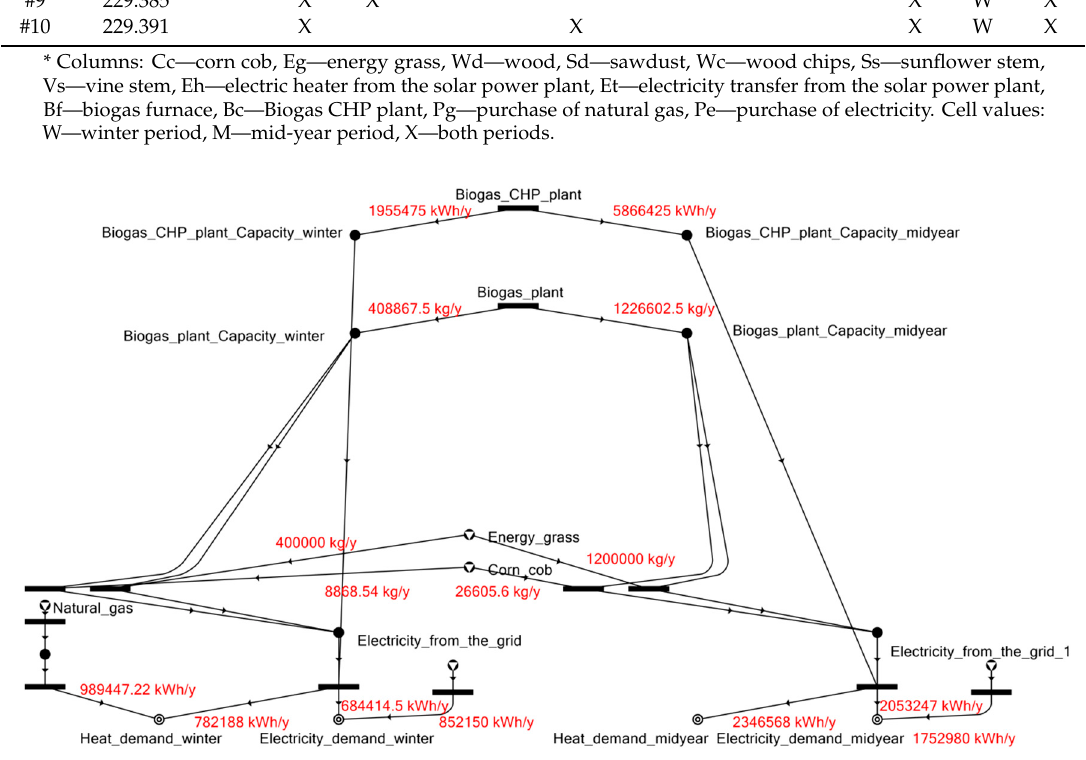
Figure 12. The optimal solution for the multi-periodic scenario, with a 20 y investment horizon, relies on corn cobs and energy grass, as well as direct purchase.